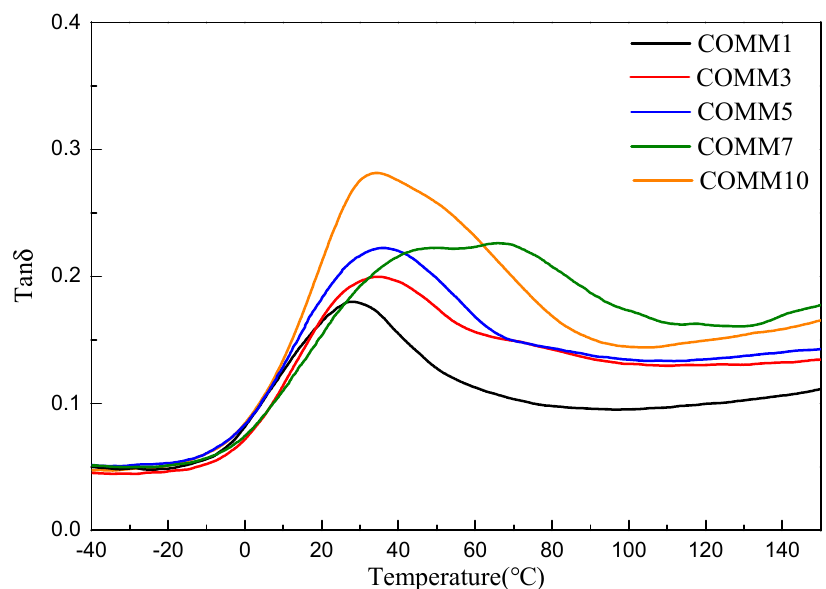
Figure 11. tan δ value for PA6 containing dimer oleic acid and 4,4'-Methylenebis(2- methylcyclohexylamine.